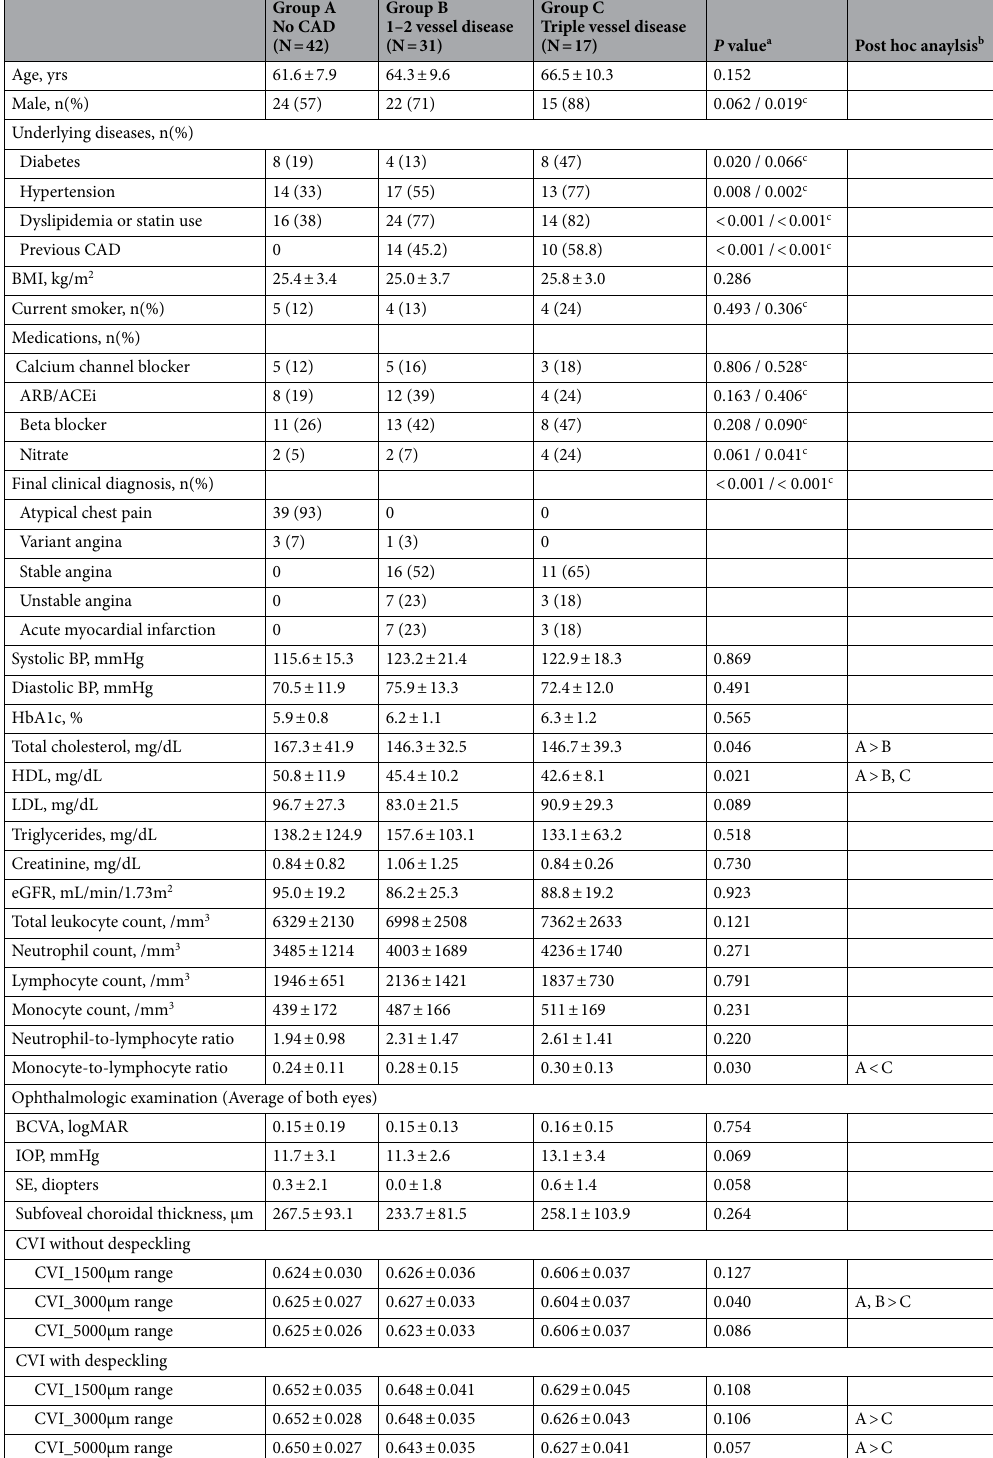
Table 1. Demographics and baseline clinical characteristics of patients with and without coronary artery disease. a Kruskal-Wallis test and chi-square or Fisher’s exact tests were used to examine continuous and categorical variables, respectively. b Post hoc analysis was performed using the Mann–Whitney U test. c P value for trend using linear by linear association. ACEi angiotensin-converting enzyme inhibitor, ARB angiotensin receptor blocker, BCVA best-corrected visual acuity, BMI body mass index, BP blood pressure, CAD coronary artery disease, CVI choroidal vascularity index, eGFR estimated glomerular filtration rate, HDL high-density lipoprotein, IOP intraocular pressure, LDL low-density lipoprotein, logMAR logarithm of the minimum angle of resolution, SE spherical